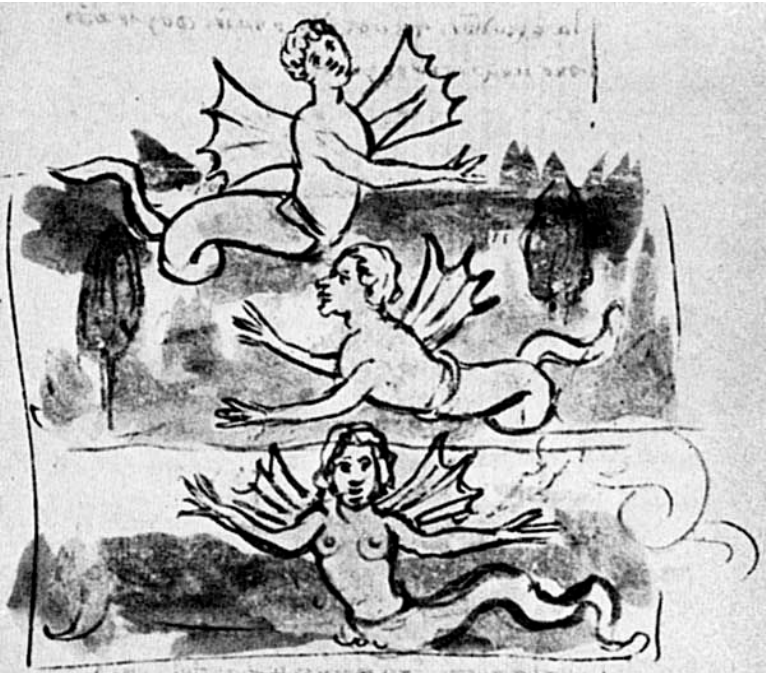
Figure 14. Winged sirens with snake-like tails, bestiary, England, Biblioteca Apostolica Vaticana, Barb. gr. 438, folio 26r.